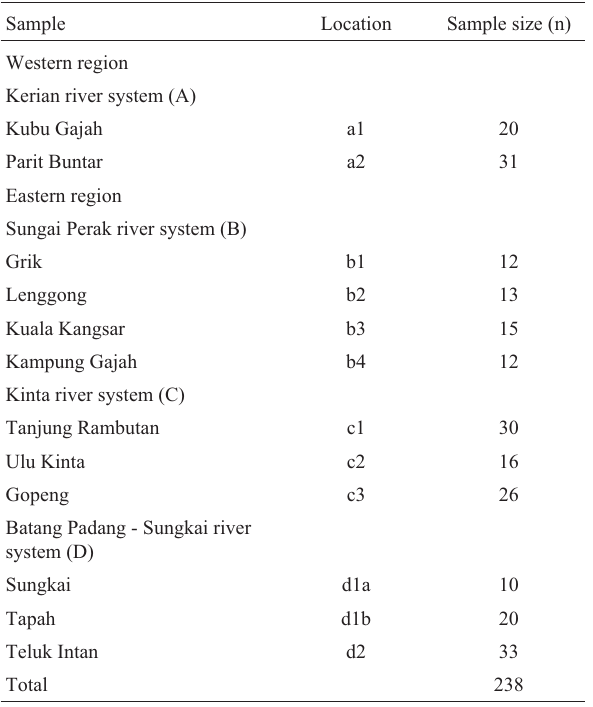
Table 1 - Sample localities and size (n) of Channa striata analysed in the present study.